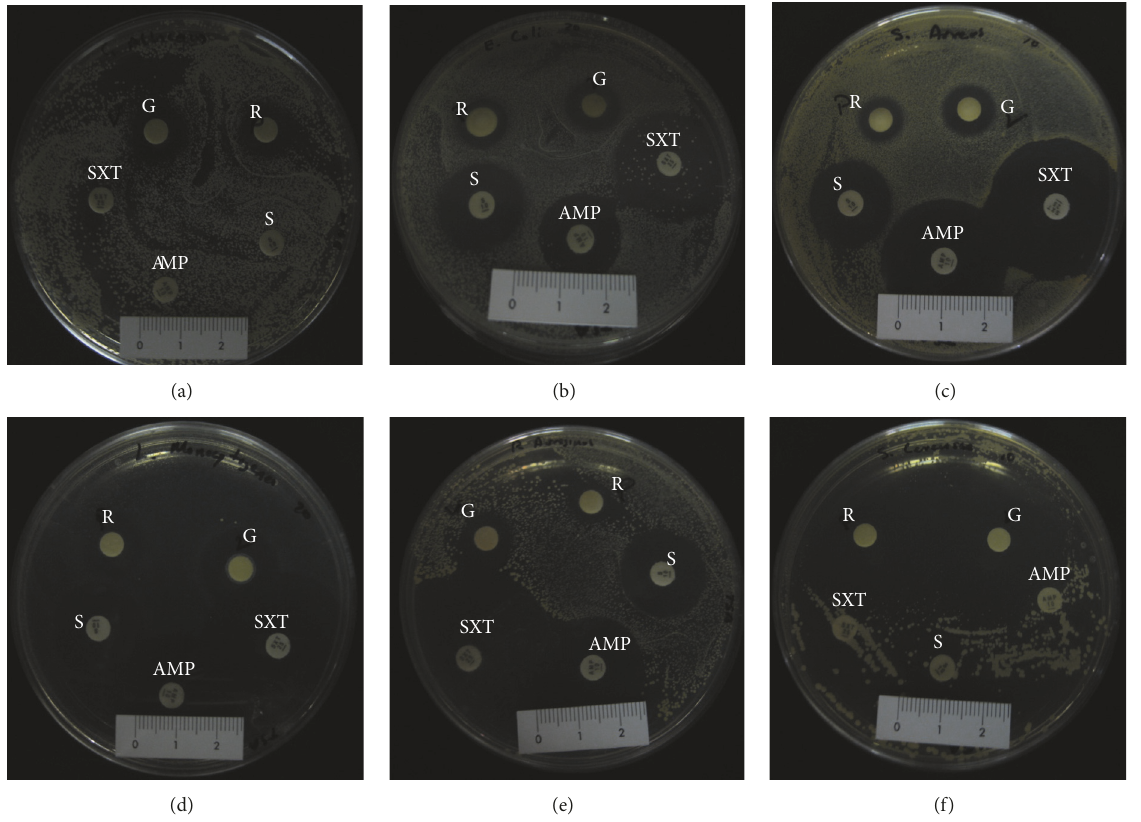
A Inhibition zone diameters for oil and reference antibiotics are means ± SE of three replicas. GCPS: green cactus pear seed oil extract, RCPS: red cactus pear seed oil extract, S: streptomycin (10 𝜇 g/disc), AMP: ampicillin (10 𝜇 g/disc), and SXT: sulfamethoxazole/trimethoprim (10 𝜇 g/disc). B ND : not detected activity. a – d Different letters in the same row indicate significant differences.